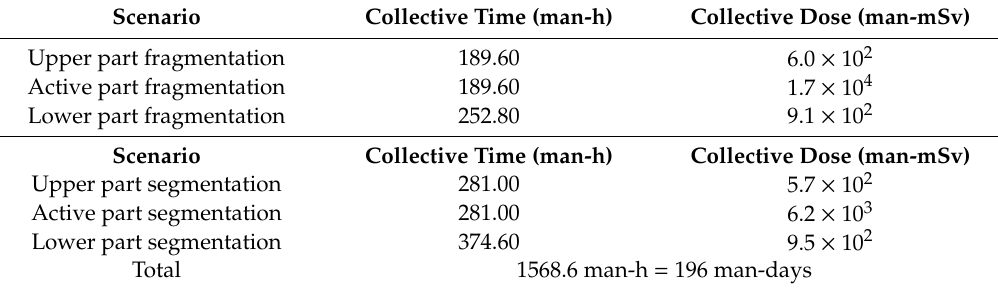
Table 15. Collective time and dose of fragmentation and segmentation processes.